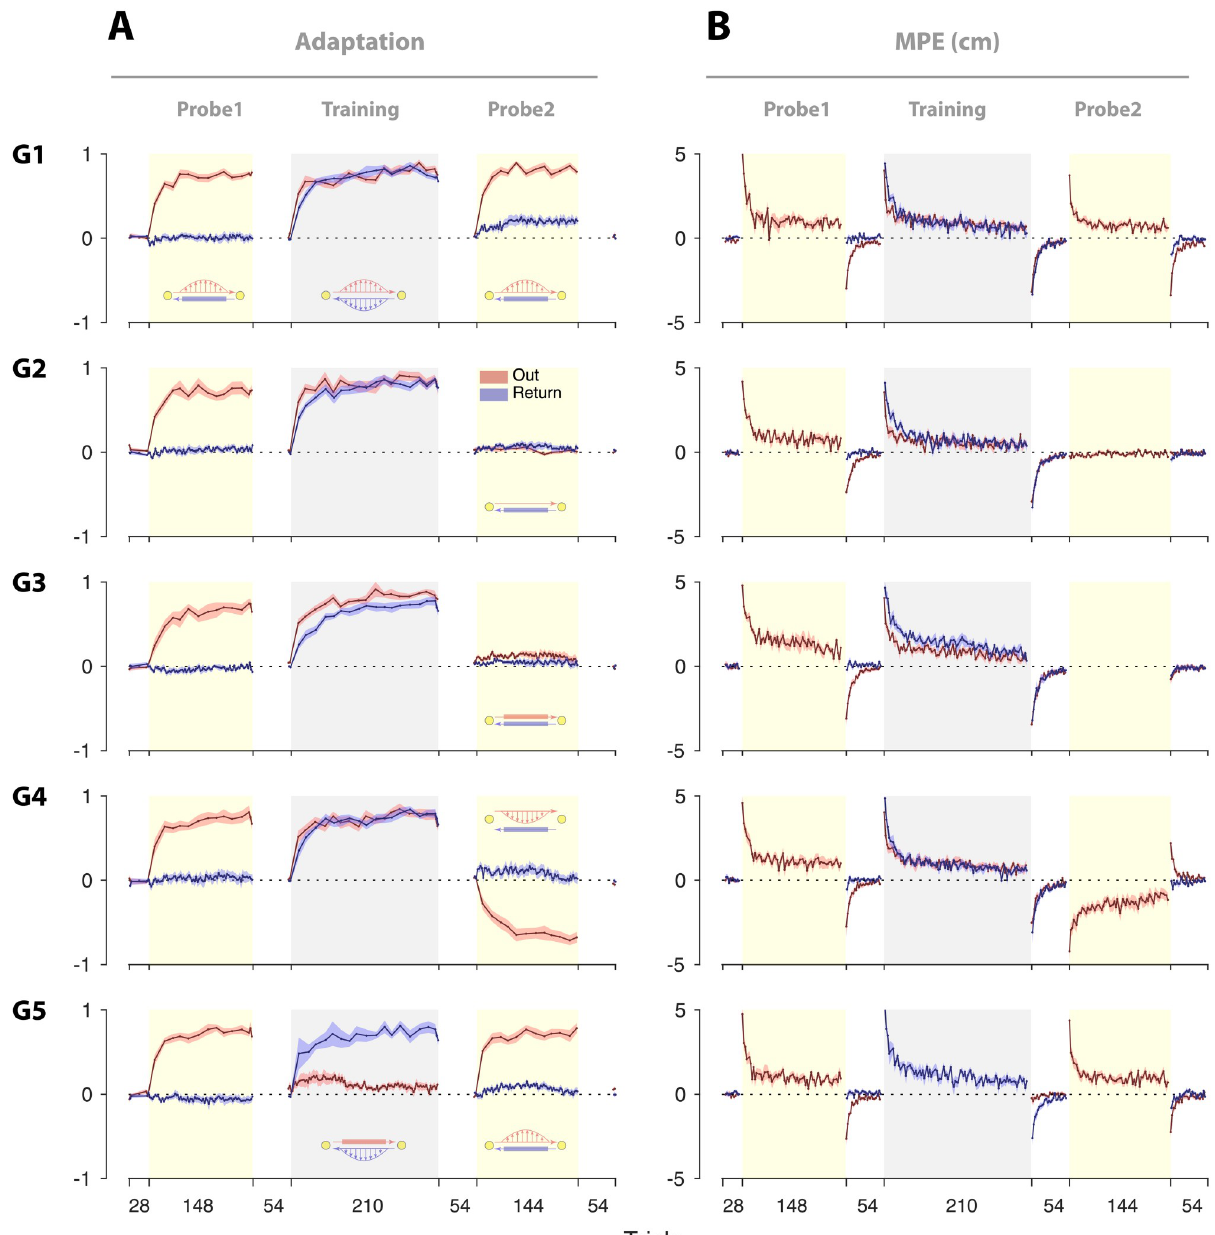
Fig 2. Performance across the three phases for the five groups. ( A ) Adaptation and ( B ) kinematic error (MPE) shown for each group (G1 to G5). Plots are mean ± s.e. across subjects for Out (red) and Return (blue) movements. The sign of the adaptation is relative to the force field experienced during training so that positive values correspond to appropriate compensation for the Training field. Similarly, MPE is positive for errors that are in the same direction as the Training force field. Note that the negative adaptation and MPE for the Out trials of Probe2, G4, reflects adaptation to the opposite force field, relative to